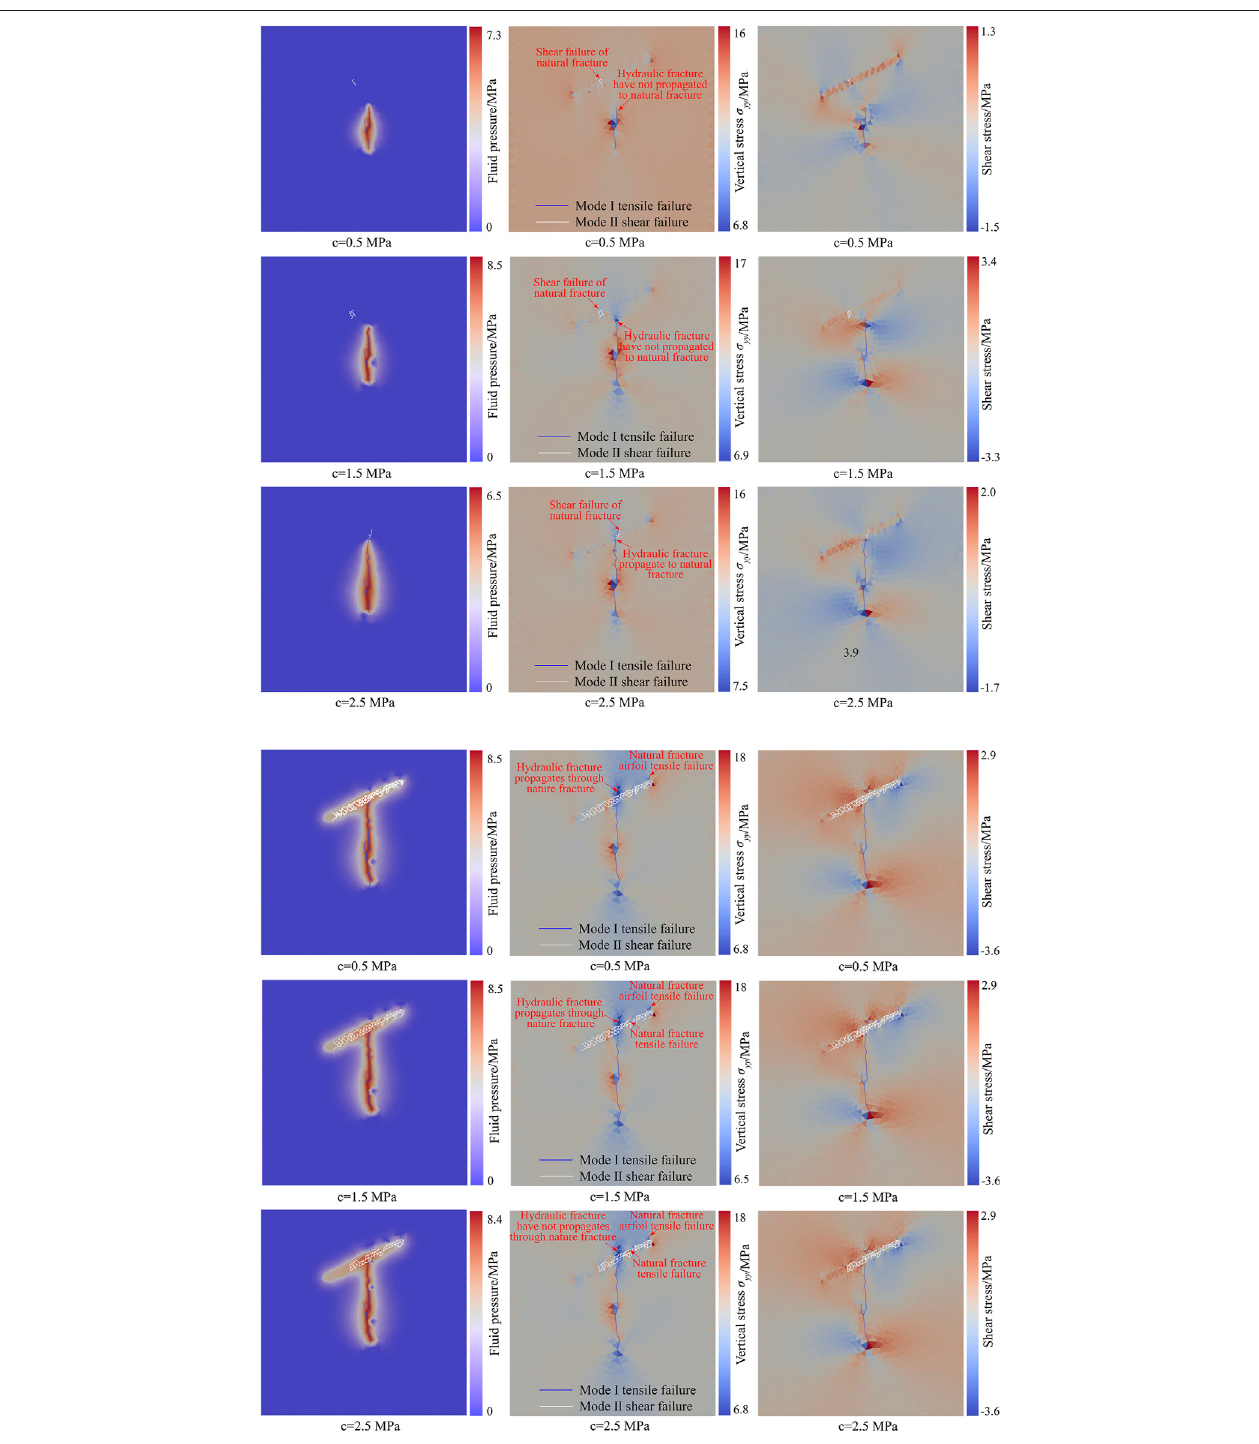
FIGURE10| Therelationshipbetweentheverticalstresspeakofnaturalfractureandthedifferenceofprincipalstressduringhydraulicfracturing. (A) Verticalstress peak; (B) shear stress peak.